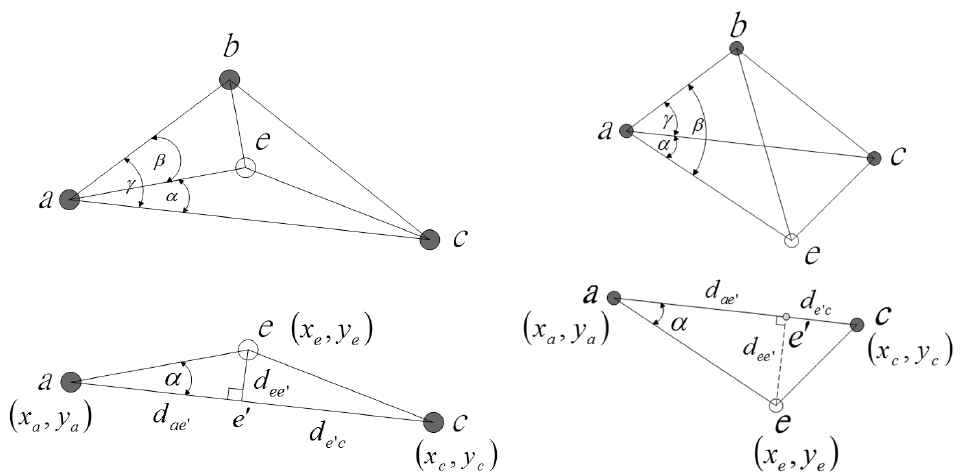
Figure 6. Two examples showing the way to compute the unknown sensor position ( x by triangulation using known distance and position